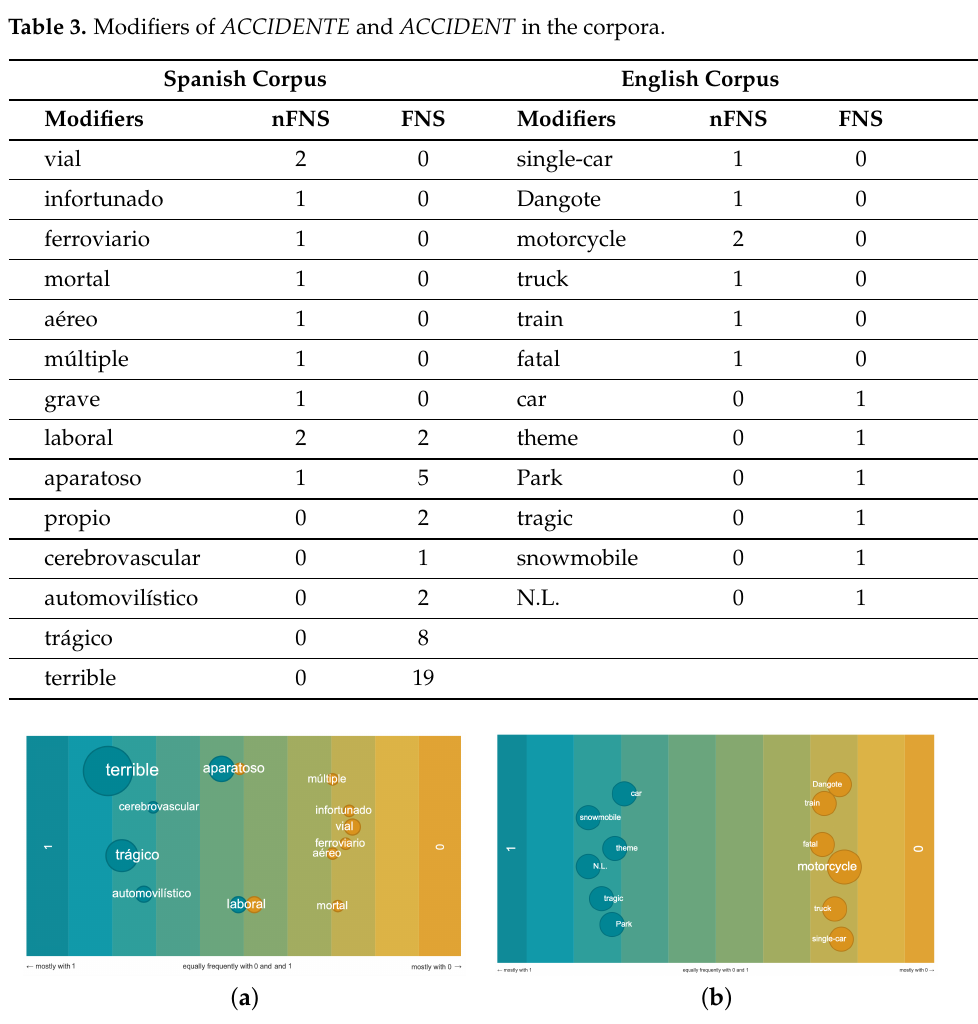
Figure 3. Visualization of modifiers of accidente and accident in the Spanish and English corpora, respectively. ( a ) Spanish corpus. ( b ) English